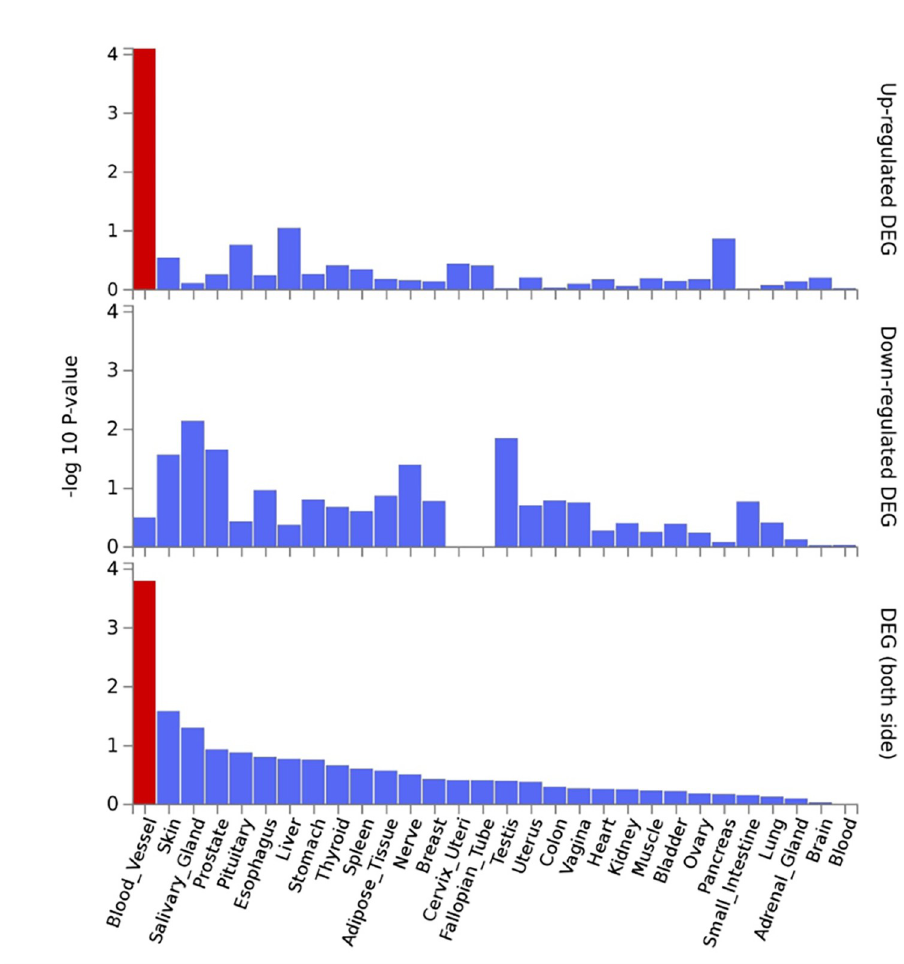
Fig 5. Gene-level tissue specificity from MAGMA analysis and GTEx database. FUMA GWAS uses MAGMA gene- level analyses and differential gene expression data from GTEx v8 to determine if the genes to which the SNPs are mapped are significantly differentially expressed in any tissues. This analysis showed that the mapped genes were significantly upregulated in blood vessels (indicated by the red